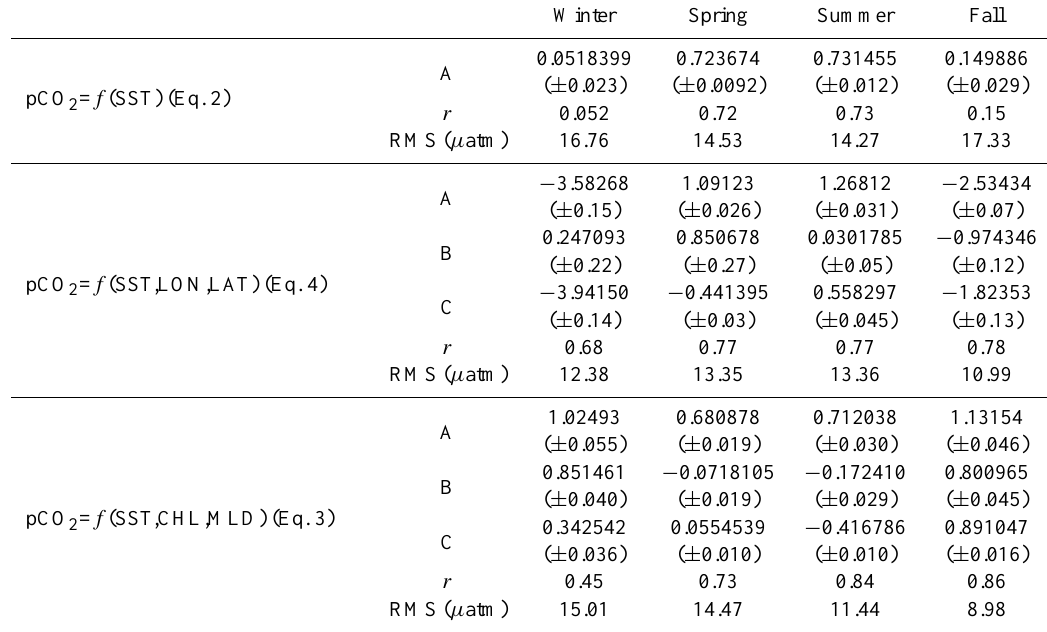
Table 2. Regression coefficients, correlation coefficients and root-mean squared errors of the three regressions (see Eqs. 2, 3 and 4).